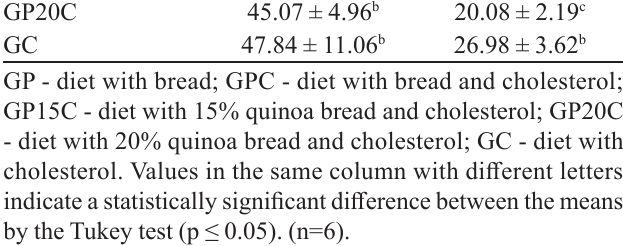
TABLE VIII - Means and standard deviations of liver lipid levels of adult rats, with and without supplementation of their diet with bread and cholesterol for 42 days GROUP